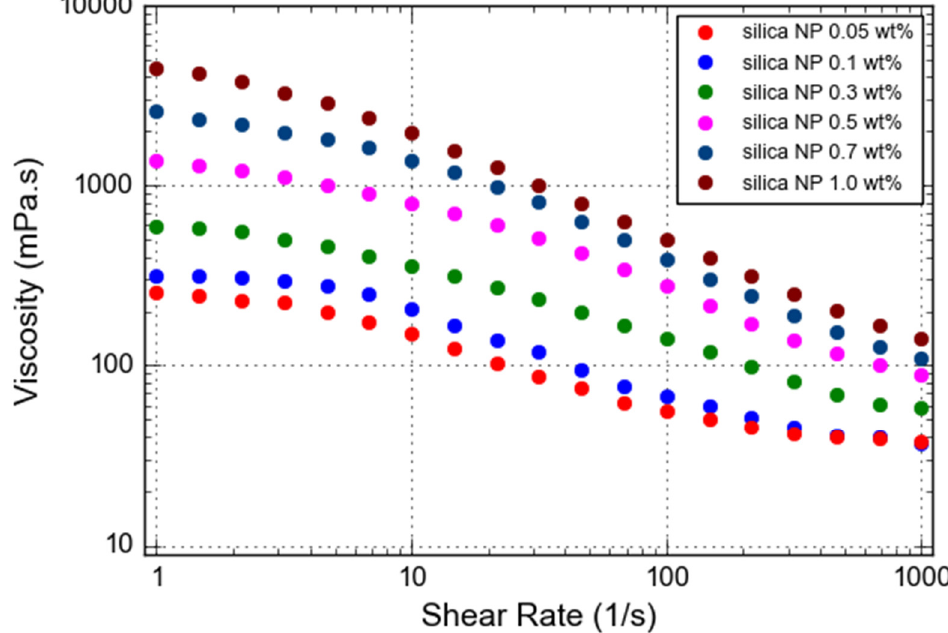
Figure 5. Viscosity as a function of shear rate for PAM/PEI polymer gelant reinforced with different silica NP amounts.